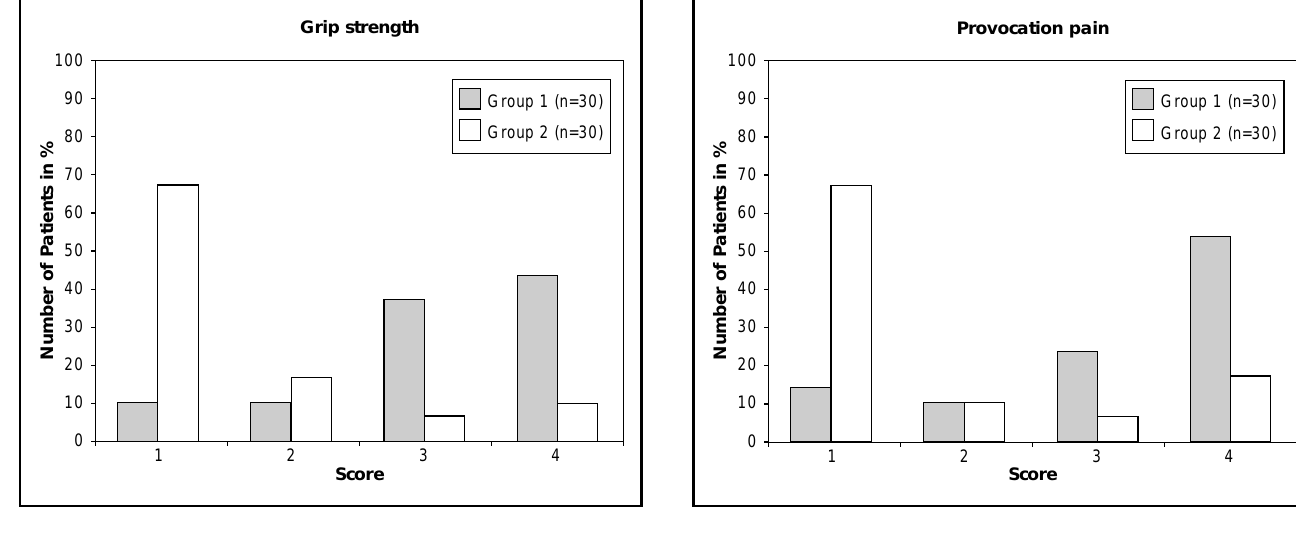
Figure 3: Distribution differences in pain on weight bearing at the end of six weeks of treatment in the therapy groups.